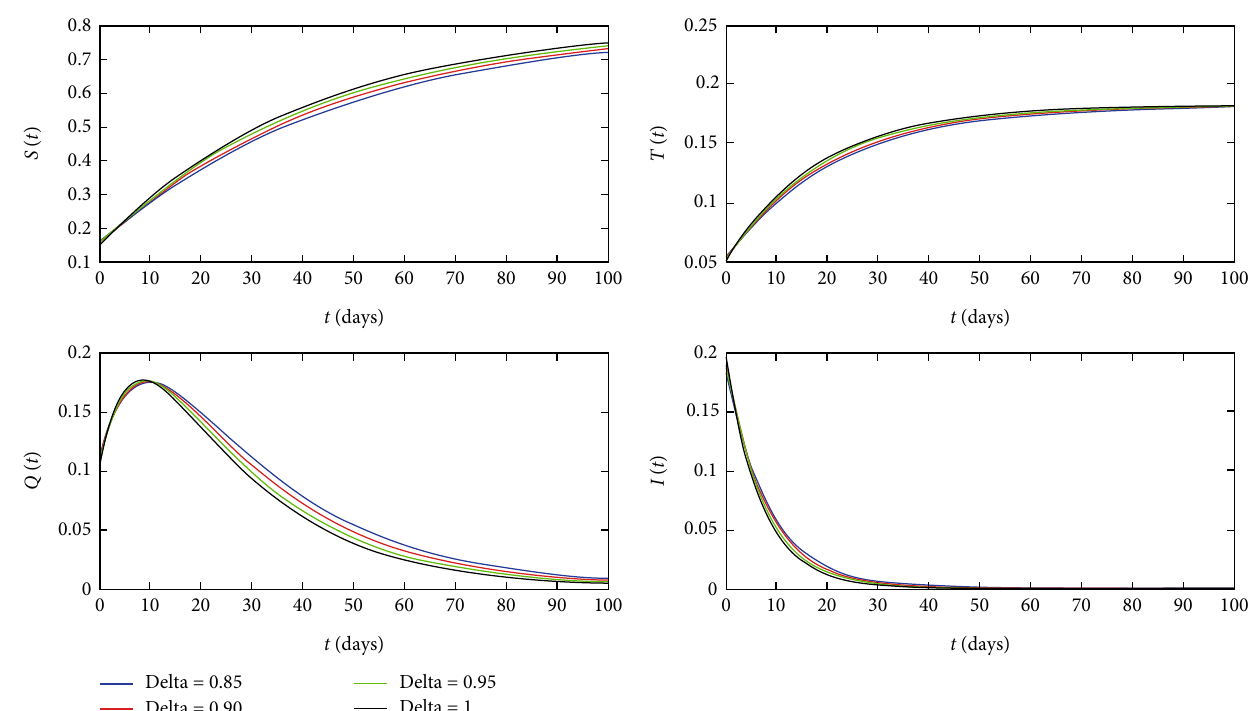
Figure 3: Time series plot of each of S ð t Þ , T ð t Þ , Q ð t Þ , and I ð t Þ for distinct values of δ